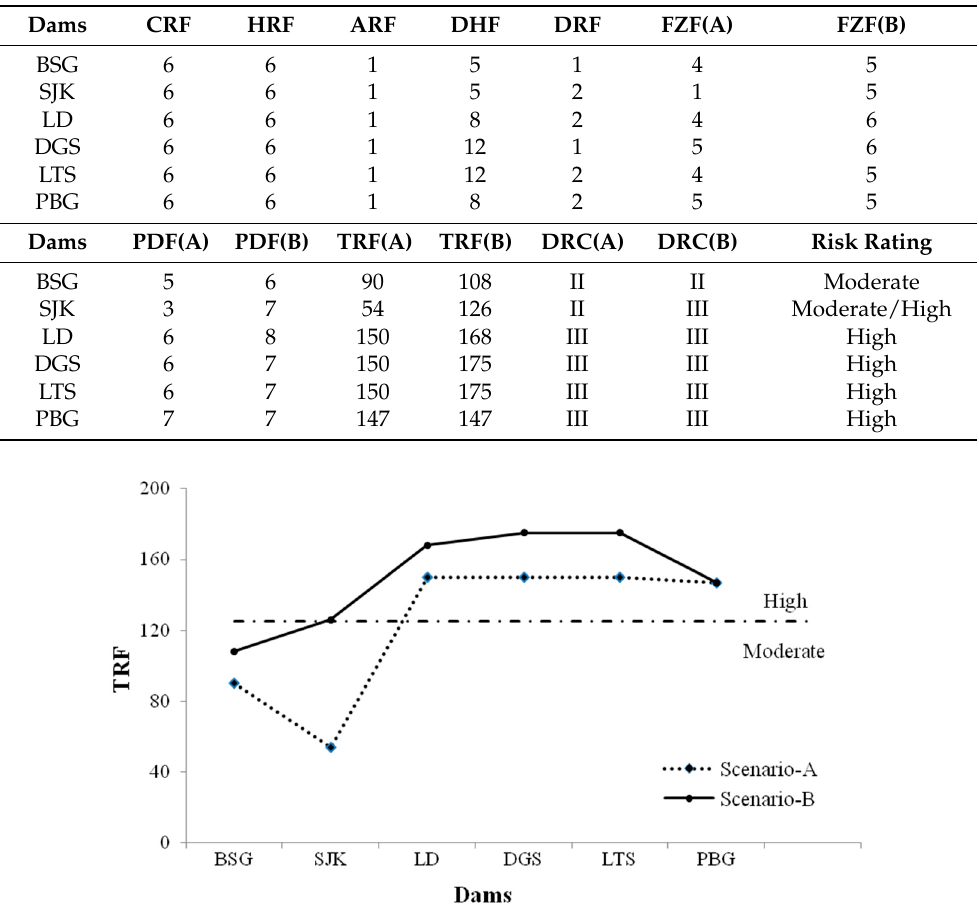
Table 10. The risk analysis results for Scenarios A and B.